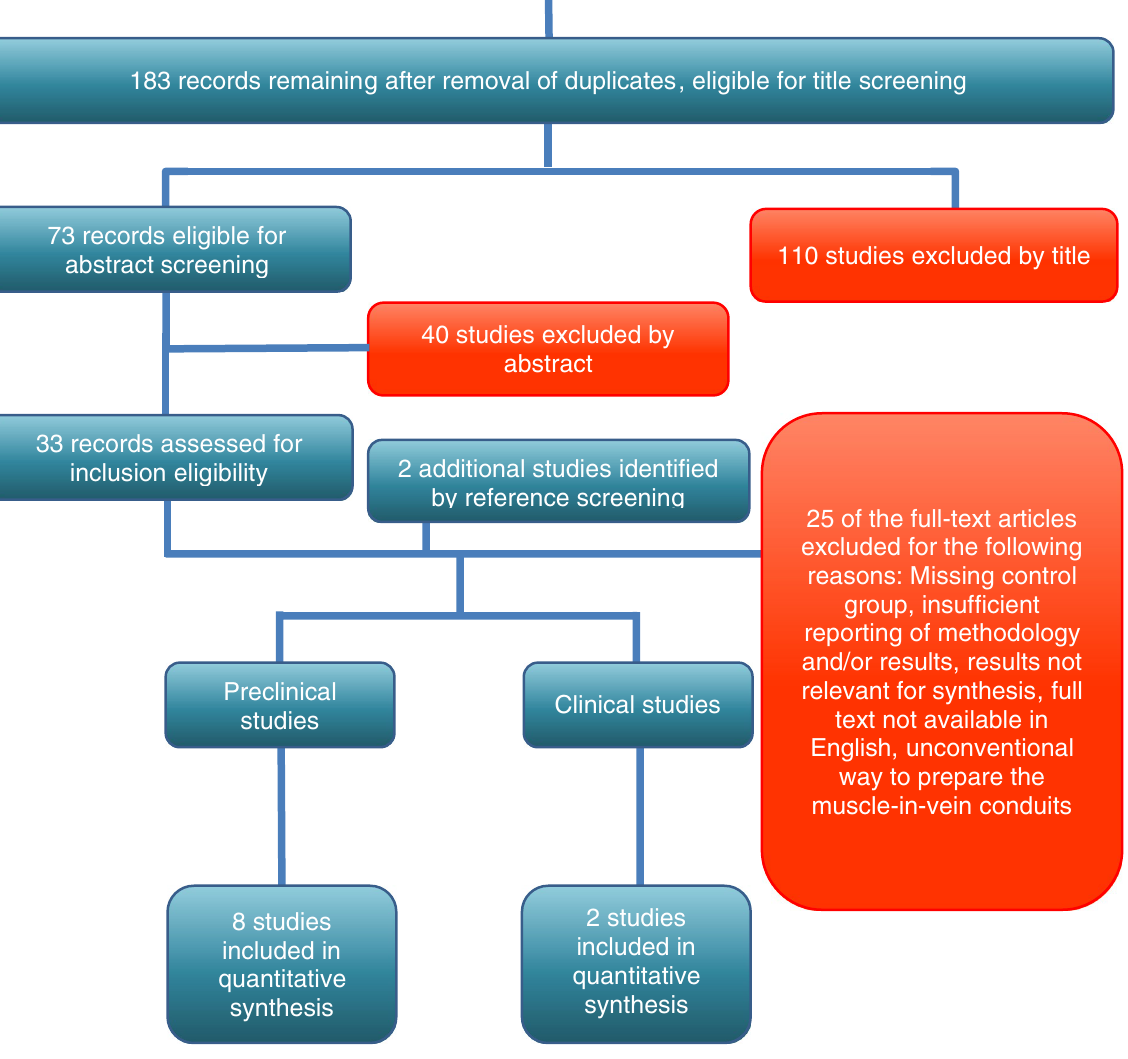
Figure 1. Flow diagram of the search and study selection process. The selection process, based on the PRISMA- guidelines, is depicted in chronological